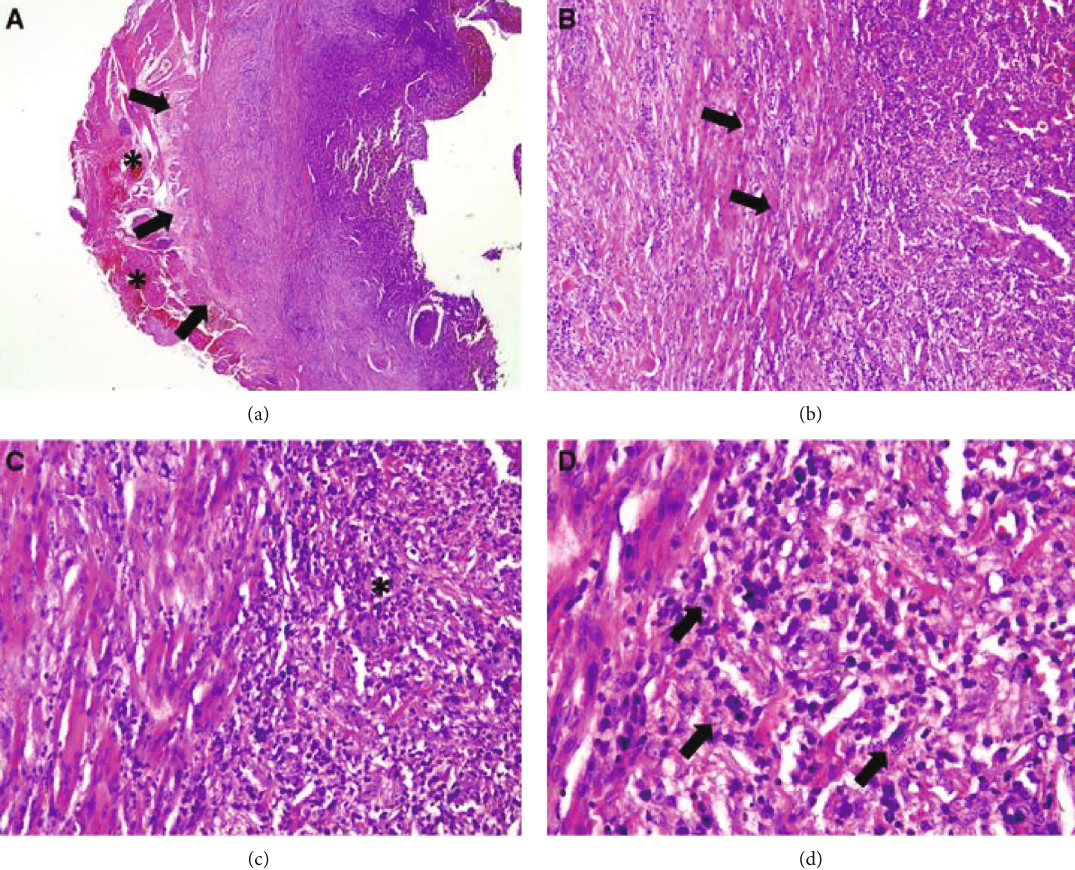
Figure 5: Histopathological examination showing a fragment of a fi brous tissue nodule well delimited by means of a capsule, with thick collagen fi bers richly peripherally vascularized and with sparse chronic in fl ammatory cells, in addition to numerous macrophages that stand out in the midst of immune-in fl ammatory cells: (a) 50x magni fi cation: the full black arrows represent the outer limit of the fi brous capsule, and the black asterisks represent the peripheral vascular congestion; (b) 100x magni fi cation: the full black arrows represent the bundles of collagen fi bers; (c) 200x magni fi cation: the black asterisk represents the chronic in fl ammatory in fi ltrate; (d) 400x magni fi cation: the full black arrows represent numerous macrophages in the middle of the chronic in fl ammatory in fi ltrate.